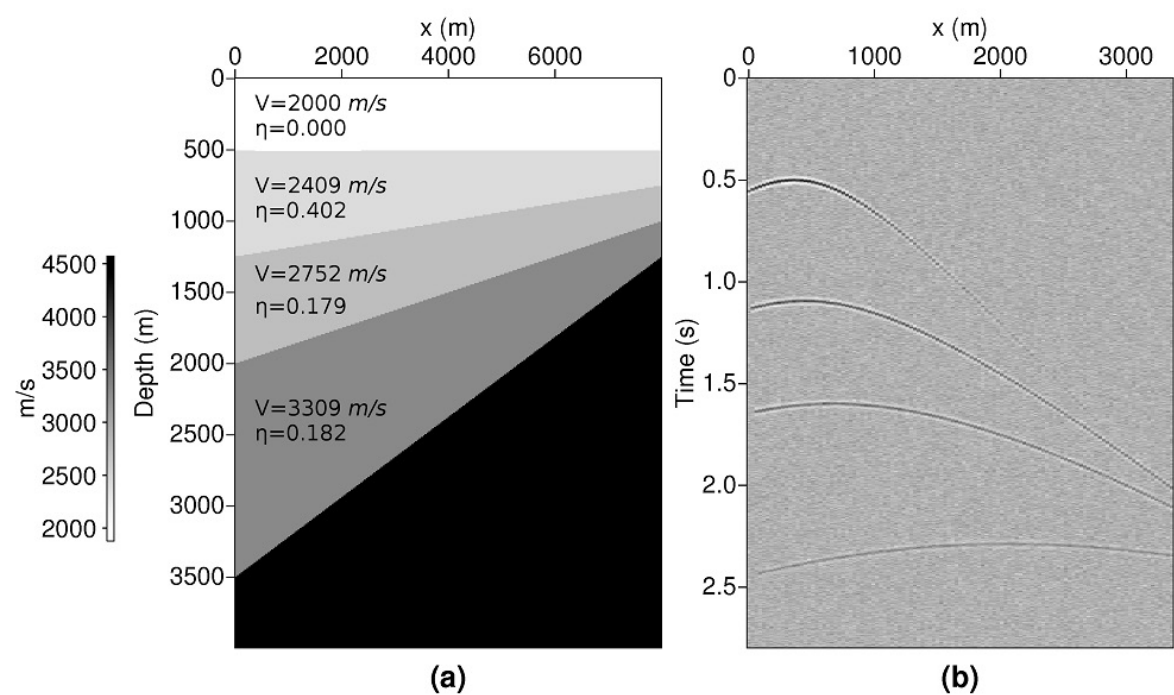
Figure 2. a) Geometry of the model 2 formed by five layers with dipping reflectors, whose degree of anisotropy increases with depth. b) A CMP family of the synthetic data obtained through